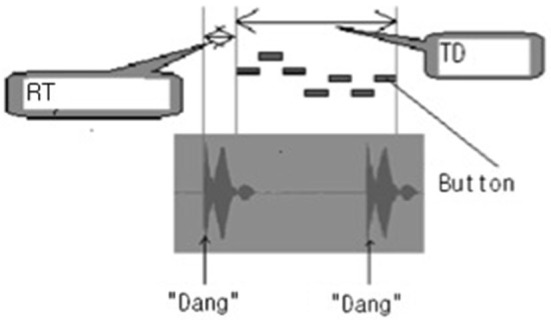
Measurements of task duration (TD) and response time (RT) on the Musical Instrument Digital Interface (MIDI) program. When the combination of numbers appeared, a “Dang” sound was heard; and when the combination of numbers disappeared, a “Dang” sound was heard. Between the two “Dang” sounds, 7 pressed buttons were expressed as 7 bars. TD represented the time interval between the start of pressing the first button and the end of pressing the last button. RT was the time interval from the onset of display of combination of numbers to pressing the first button. It was expressed in millisecond (ms).